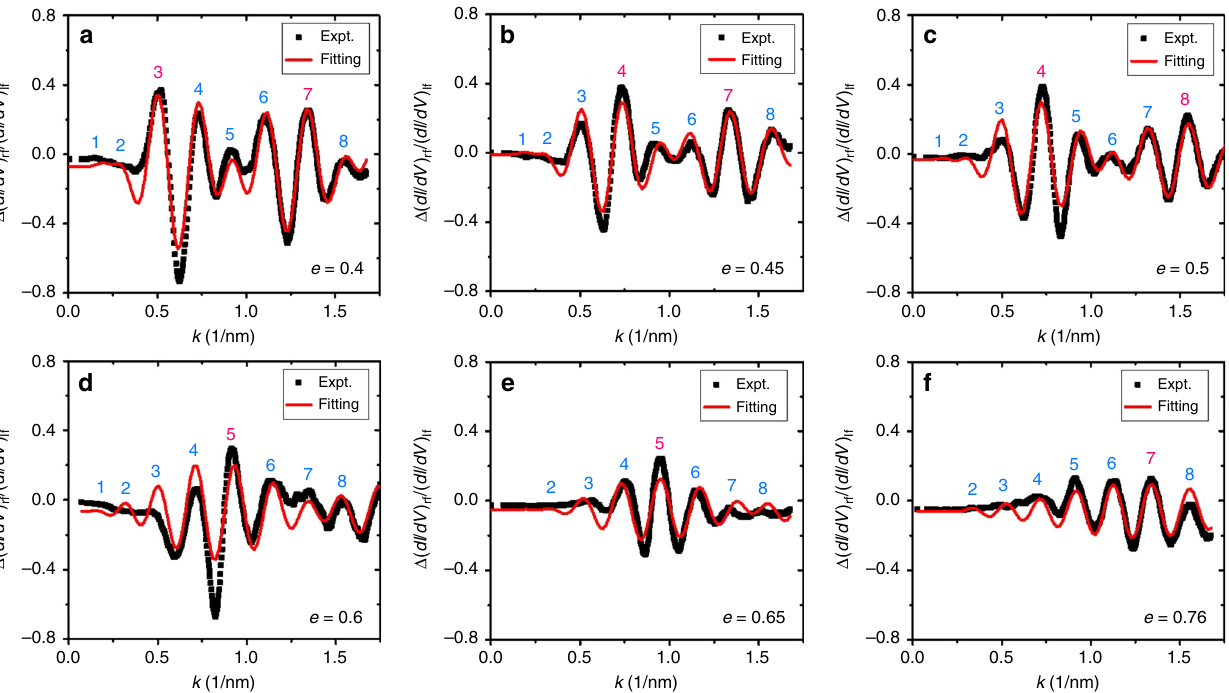
Fig. 2 e -dependent transfer function. a – f The transfer function of quantum mirage in EQCs with fi xed a = 7.6 nm and e = 0.4 – 0.76, as indicated. Black squares are the experimental data, and red curves are the fi ttings utilizing Eq. (2). The peaks are marked by numbers de fi ned in Eq. (3). The magenta numbers are distinguished from the cyan ones to mark the central peaks. The values of wavenumber k are obtained using the dispersion relation discussed in main